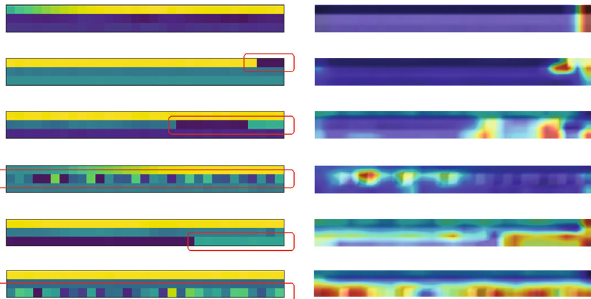
Figure 19: Illustrative CAM plots for the 6 cases (top to bottom, cases 0 ~ 5 in Table 4); the highlighted (red hot) features correspond to the faults occurred on the state image (marked with red